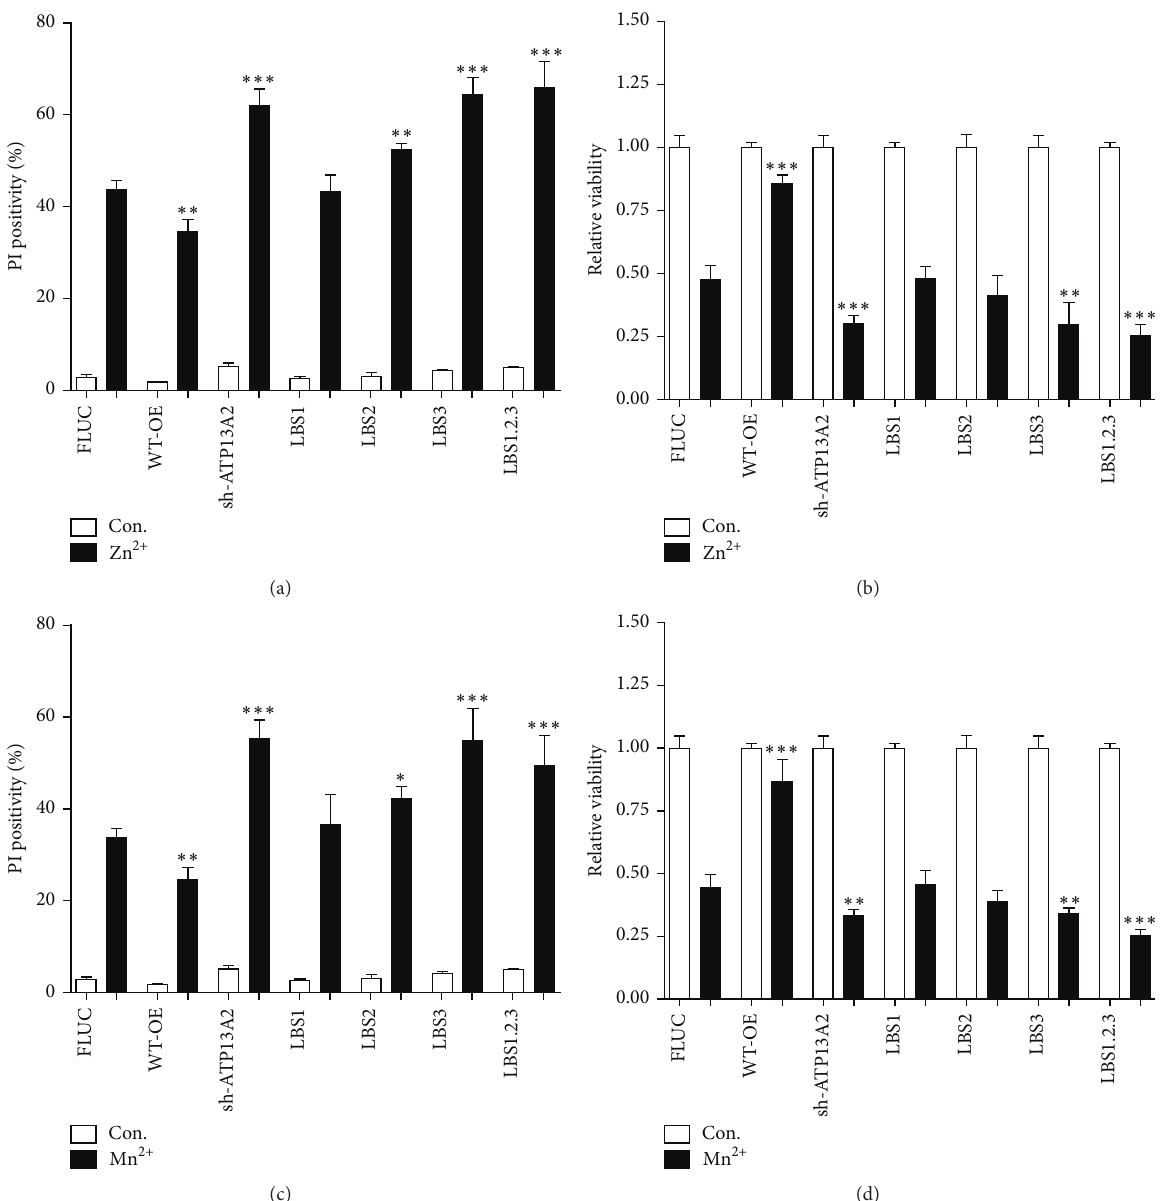
Figure 5: The capacity of ATP13A2 to interact with PA/PI(3,5)P2 is essential to protect against heavy metal-induced cytotoxicity. SHSY5Y cell lines stably overexpressing FLUC, ATP13A2 shRNA, ATP13A2 WT, and LBS1–3 mutants were exposed to toxic heavy metal concentrations of Zn 2+ (150 𝜇 M ((a) and (b))) or Mn 2+ (2 𝜇 M ((c) and (d))). Cell death induction was assessed by propidium iodide (PI ) based flow cytometry ((a) and (c)) and cell viability by MUH assay ((b) and (d)). Data are the mean of 3 independent experiments ± SD. ∗ statistical differences between FLUC and WT-OE/sh-ATP13A2/LBS1/LBS2/LBS3/LBS1.2.3 (1 mark, 𝑃 < 0.05 ; 2 marks, 𝑃 < 0.01 ; 3 marks, 𝑃 < 0.001 ) (ANOVA with Bonferroni post hoc